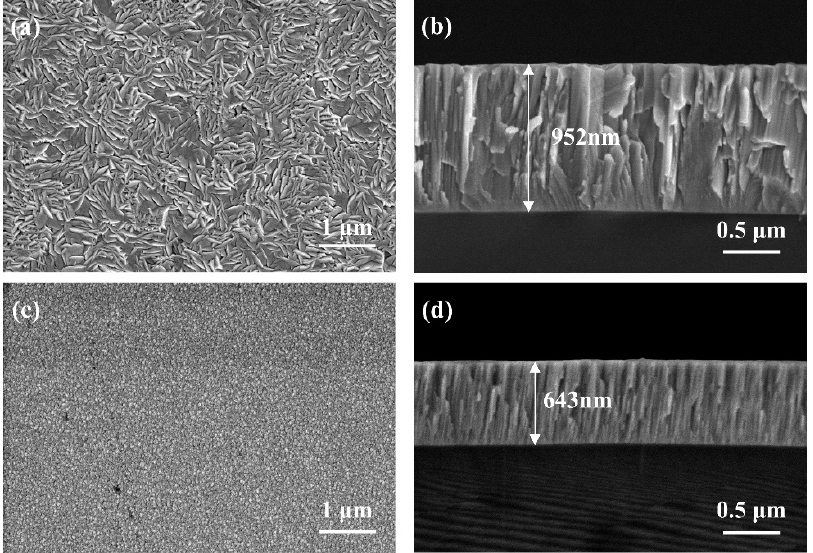
Figure 3. The SEM morphologies of the films: ( a ) surface of HEA film, ( b ) cross-section of HEA film, ( c ) surface of HEN film, and ( d ) cross-section of HEN film.